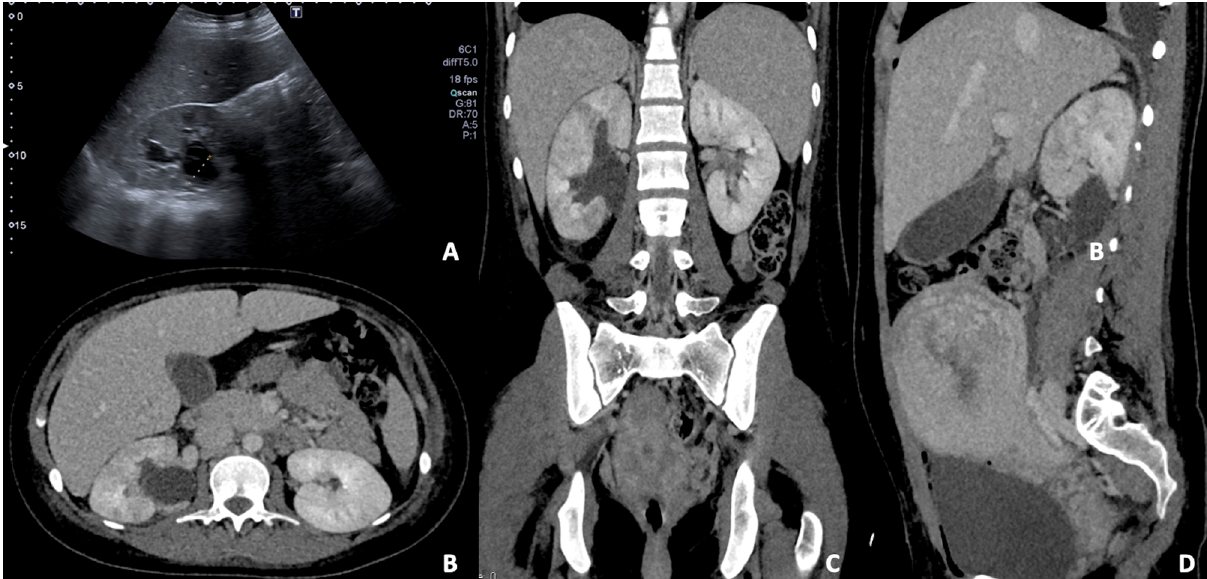
Figure 11. ( A ) US B-mode scan in a pregnant woman diagnosed with pyelonephritis and moderate dilatation of the right renal pelvis. Contrast-enhanced CT axial ( B ), coronal ( C ), and sagittal ( D ) images in the venous phase of the same patient after delivery. The right kidney appears slightly enlarged than the left one with persistent pelvis dilatation; some focal wedge-like regions of reduced enhancement are detected, confirming the presence of peri-partum pyelonephritis.